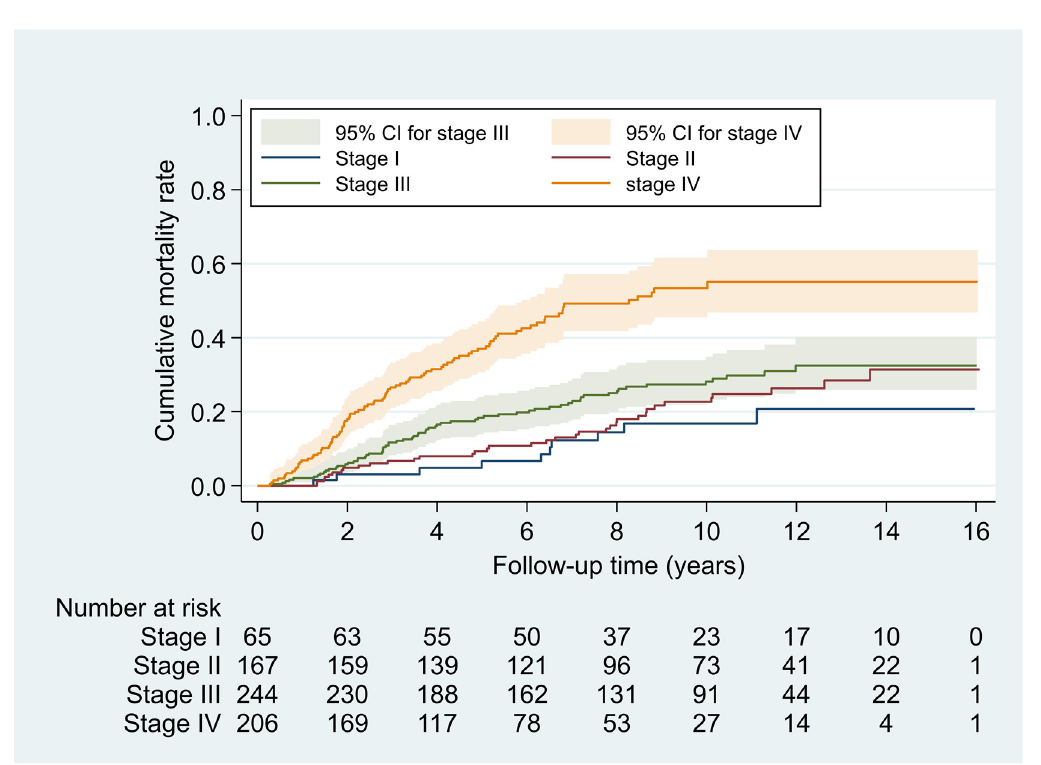
Figure 1. Cumulative mortality rates of nasopharyngeal cancer patients associated with AJCC stages. Note: Cumulative mortality rates were estimated from the Kaplan–Meier estimators. Log-rank test was used to test the equality of cumulative mortality rates between AJCC stages (difference in 4 AJCC stages, χ 2 = 61.65, p < 0.001; difference in AJCC stage I–II versus III–IV, χ 2 = 22.66, p < 0.001). CI, confidence interval.